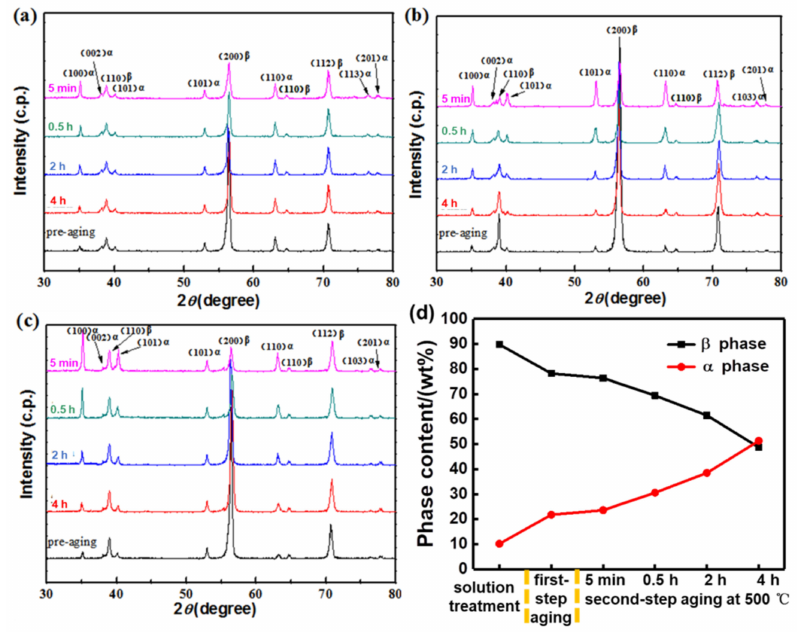
Figure 4. XRD pattern after HLDA at different temperature: ( a ) 450 ◦ C, ( b ) 500 ◦ C, ( c ) 550 ◦ C, ( d ) phase content of 500 ◦